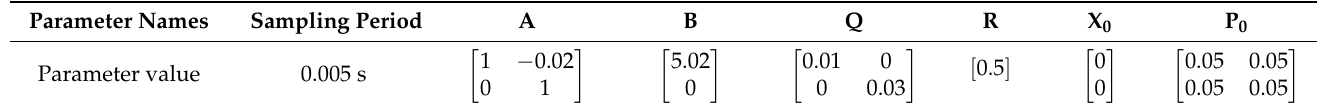
Table 3. Filter initialization